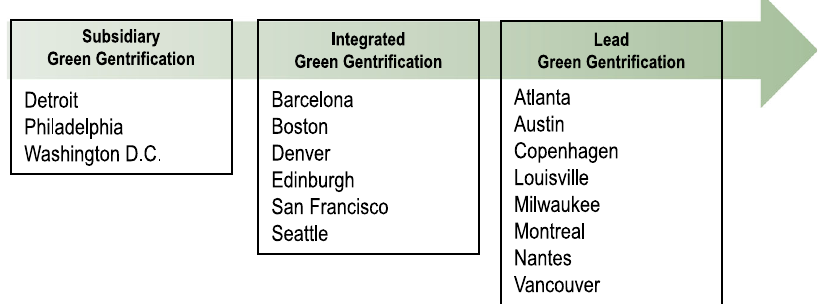
Fig. 4 Green gentri fi cation types. Analysis reveals three types of green gentri fi cation cities. In “ lead green gentri fi cation ” cities, greenspace is the standout driver of gentri fi cation. In “ integrated green gentri fi cation ” cities, greenspace demonstrates is likely a relevant driver of gentri fi cation to a degree that is roughly equal to other built environment changes, like new transit and new development. In “ subsidiary green gentri fi cation ” cities, greenspace is likely a relevant driver of gentri fi cation, but it is less impactful than other built environment